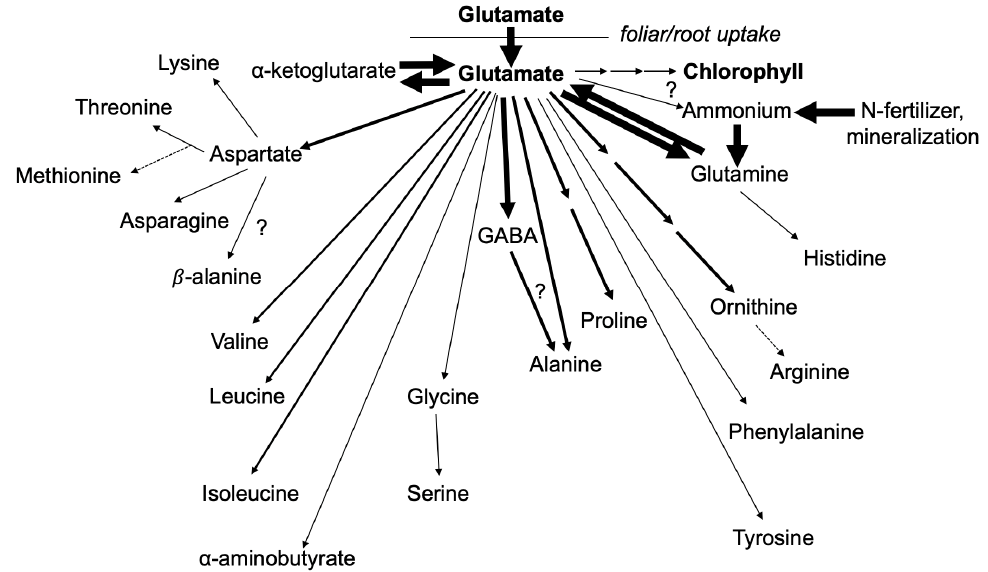
Figure 1. Glutamate occupies a central position in plant amino acid metabolism. The arrows indicate the multiple fates for the carbon backbone and/or amino group of glutamate in plant cells. The arrow thickness approximately correlates with relative flux toward each metabolite. The arrows labeled with a question mark (aspartate to 𝛽 -alanine (aspartate decarboxylase), GABA to alanine (GABA: pyruvate aminotransferase), and glutamate to ammonium (glutamate dehydrogenase)) denote that are